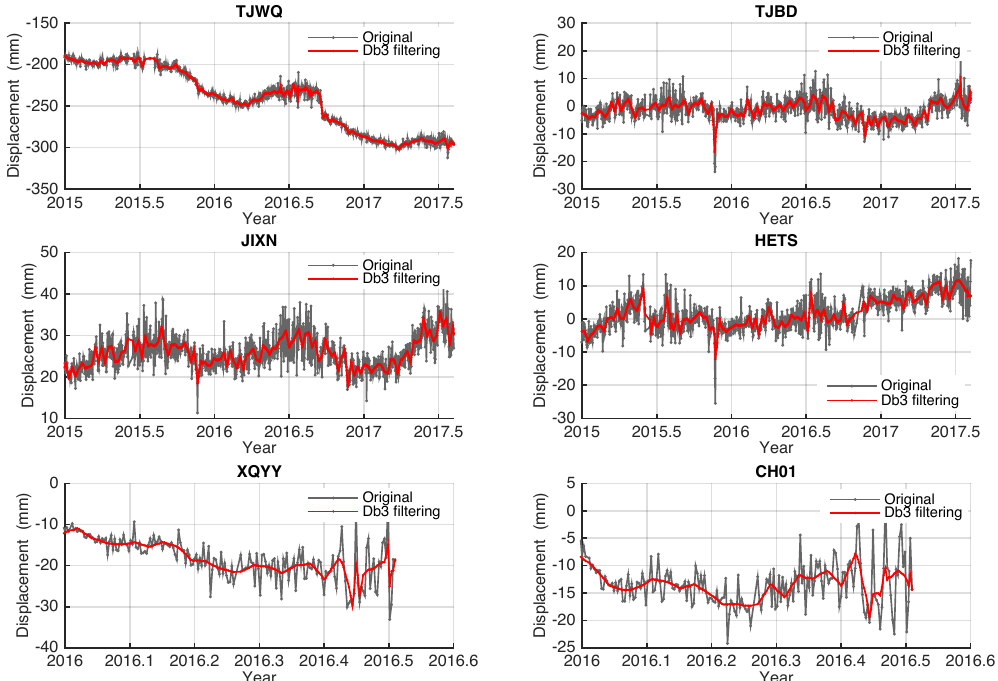
Figure 8. Comparison of the original and filtered GPS vertical deformation time series. The grey line denotes the original GPS time series and the red line denotes the time series filtered with a Db3